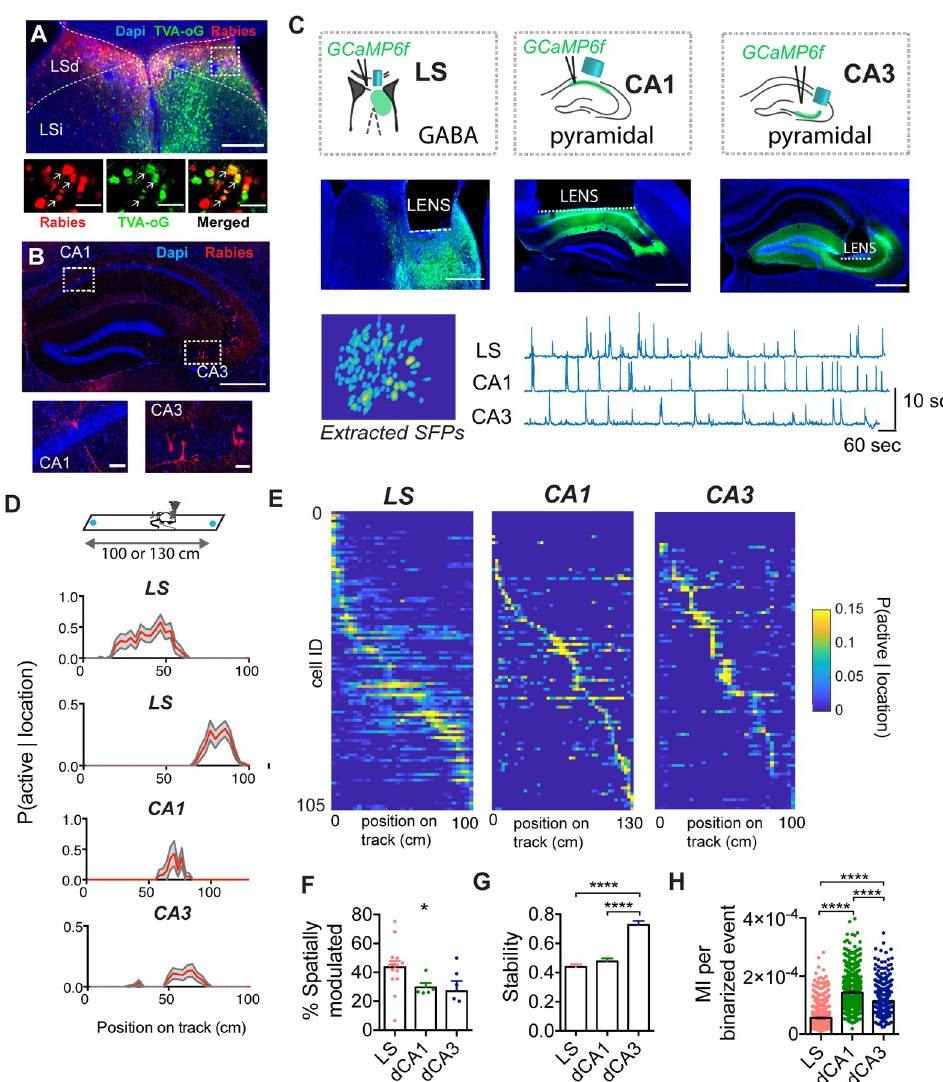
Fig 1. LS shares spatial coding characteristics with its main hippocampal inputs CA1 and CA3 during goal directed navigation in a 1D environment. ( A) Retrograde rabies tracing injection site, blue: DAPI staining, green: TVA.oG coupled to an eGFP, red: Rabies coupled to mCherry, orange: starter cells expressing both TVA.oG.eGFP and Rabies.mCherry. (B) Retrograde labeling in the dorsal hippocampus, coronal section. Bottom left: example of mCherry- positive CA1 pyramidal cell, bottom right: mCherry-positive CA3 pyramidal cells, blue: DAPI staining, red: Rabies coupled to mCherry. (For additional images, see S1 Fig). (C) Top: diagram of one-photon calcium recording setup in LS, CA1, and CA3 in freely behaving mice, with GCaMP6f expression restricted to GABAergic cells in LS and restricted to pyramidal cells in dorsal CA1 and CA3, middle: histological verification of implantation site (see also S2 and S3 Figs), and bottom: extracted calcium transients for LS, CA1, and CA3. (D) Top: linear track paradigm, with sucrose rewards on either end. Bottom: probability of an example cell to be active given the location on the linear track (red) with 95% upper and lower percentile (gray). Examples shown are from 2 different LS mice and a representative spatially modulated cell from one CA1 and CA3 animal each. (E) Activity of cells sorted along location in the maze for each region (blue, low; yellow, high). (F) Percent of significantly spatially modulated cells for each animal for each recording region. LS: N = 15 mice. CA1: N = 5 mice, N = 6 mice. (G) Within-session stability of spatially modulated cells in each region active (LS: n = 475 cells, CA1: n = 336 cells, CA3: n = 143 cells). (H) MI per binarized event for all cells (LS: n = 1,030 cells, n = 15 mice. CA1: n = 1251 cells, n = 5 mice, CA3: n = 464 cells, n = 6 mice). � , p < 0.05, �� , p < 0.01, ���� , p < 0.0001. Test used in F–H: Kruskal–Wallis with Dunn’s multiple comparisons test. The underlying data can be found in S1 Data. eGFP AU : AbbreviationlistshavebeencompiledforthoseusedinFigs 1 (cid:0) 7 : Pleaseverifythatallentriesarecorrect : , enhanced green fluorescent protein; LS, lateral septum; LSd, dorsal lateral septum; LSi, intermediate lateral septum; MI, mutual information; SFP, spatial footprint.